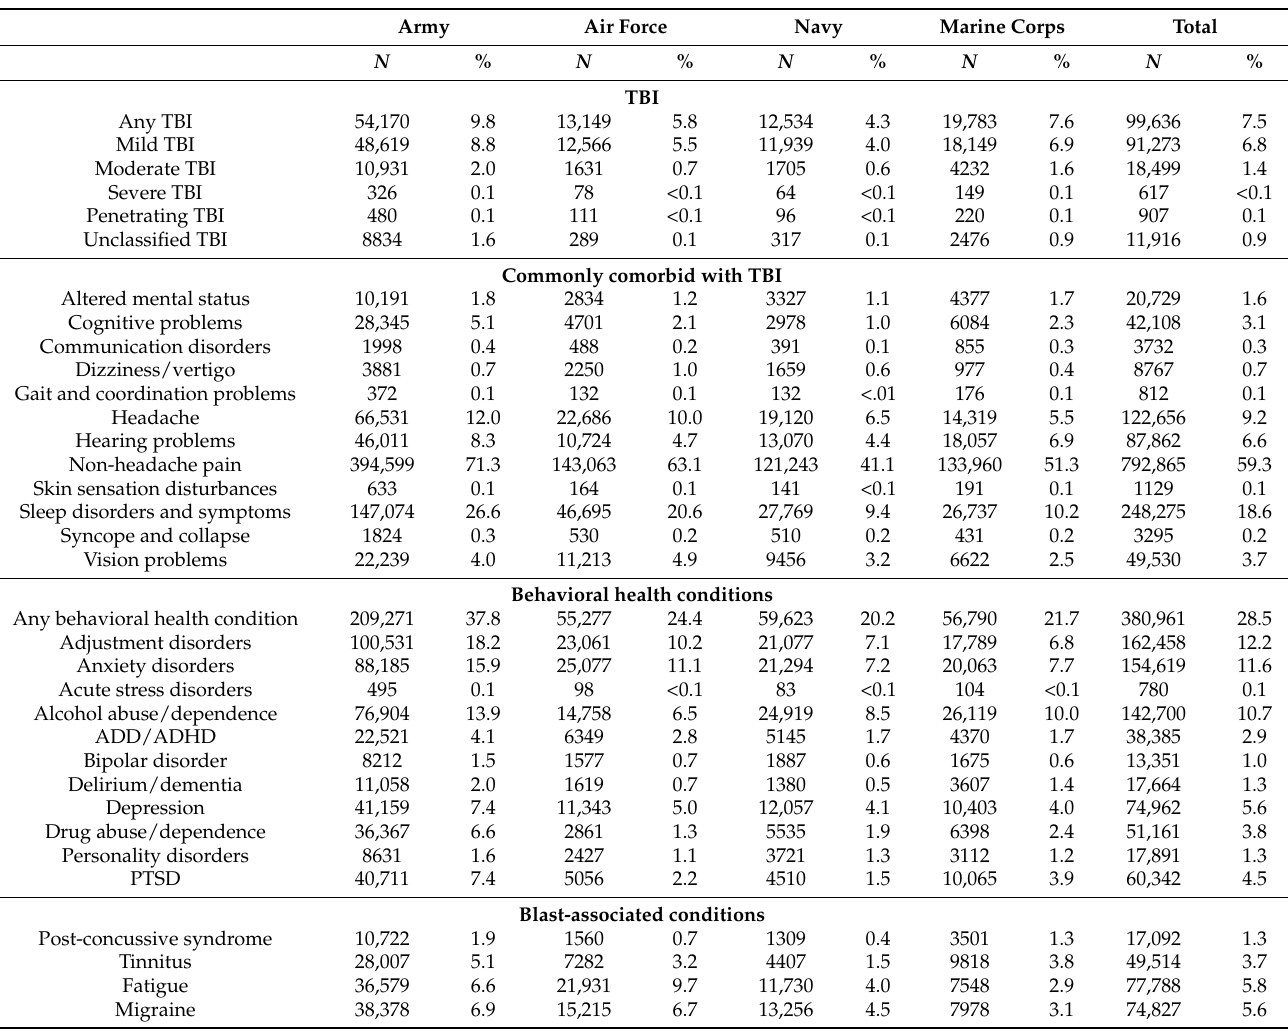
Table 1. Frequencies of each condition across the entire sample, stratified by branch of